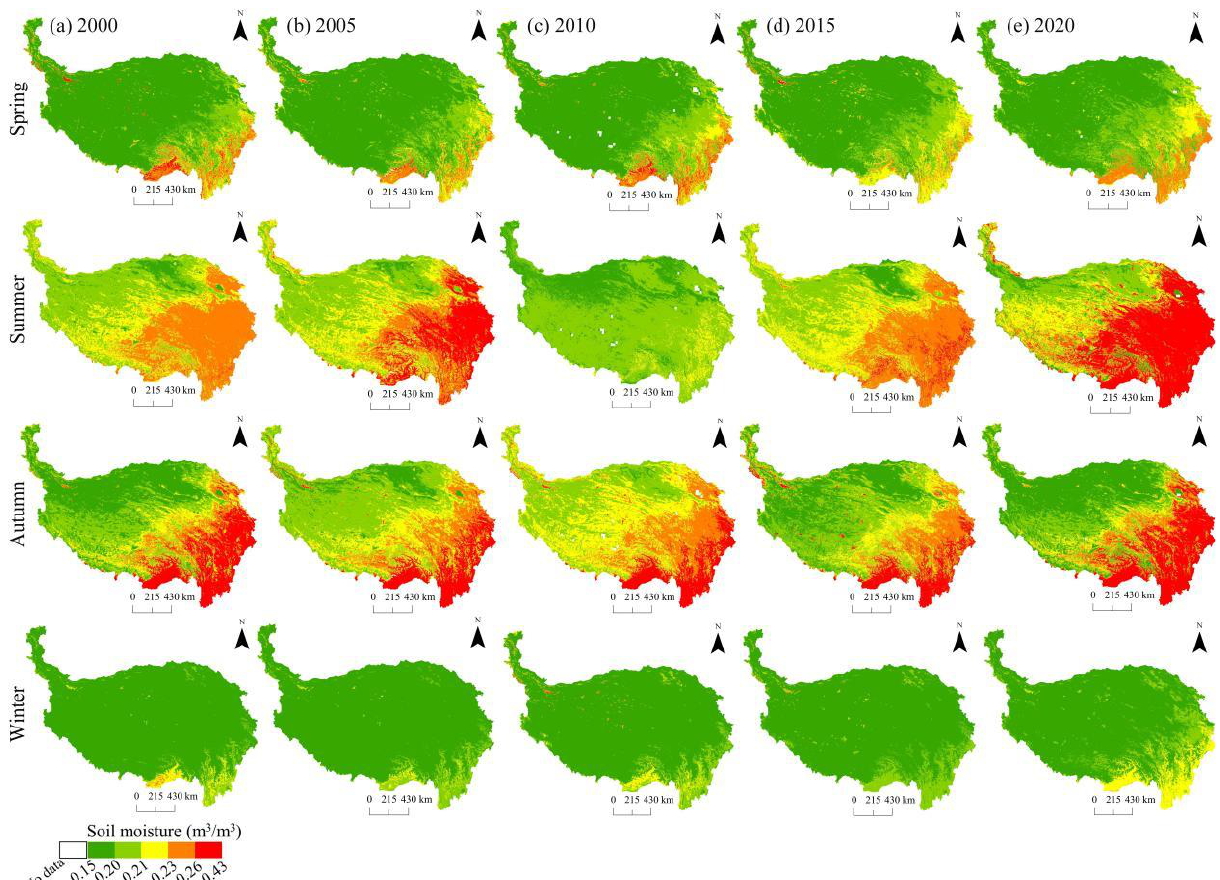
Figure 4. Spatial patterns of seasonal SM in the TP from 2000 to 2020, ( a ) 2000, ( b ) 2005, ( c ) 2010, ( d ) 2015, and ( e ) 2020, respectively.